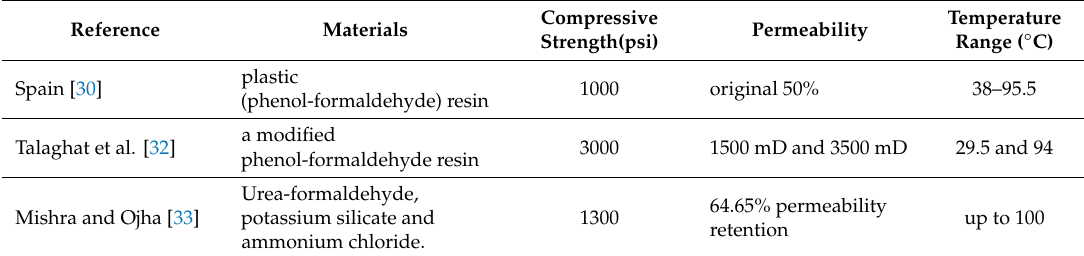
Table 1. Phenol-formaldehyde resin and urea-formaldehyde resin methods to consolidate sand formation.